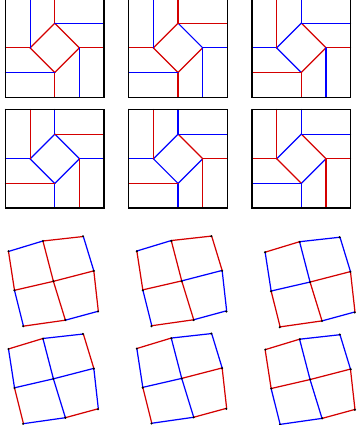
Fig. 8. The 6 possible unique square twist crease patterns and their corresponding graphs given Theorem 2.